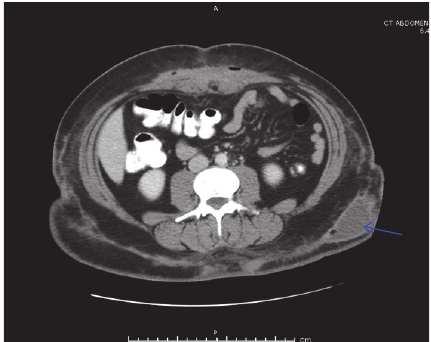
Figure 1: CT abdomen and pelvis with intravenous contrast show- ing large subcutaneous collection in the anterior abdominal wall (blue arrow) suggestive of abscess.